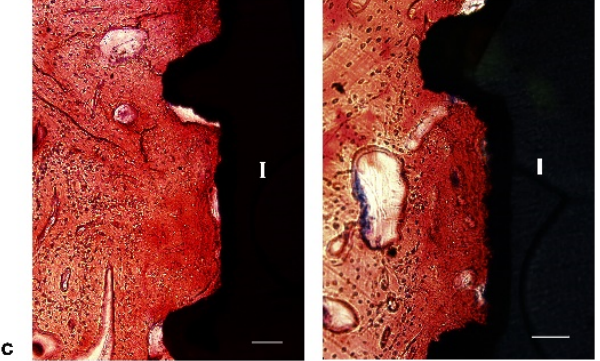
Figure 5. Light micrographs of XiVE ® implant longitudinal sections treated without (left panels) or with (right panels) nacre powder. ( a ) At week 2. ( b ) At week 4. ( c ) At week 6. The dotted line indicates the interface between the old and new bone; I, implant. Bar = 100 µm. Stevenel’s blue and Alizarin red S stain.